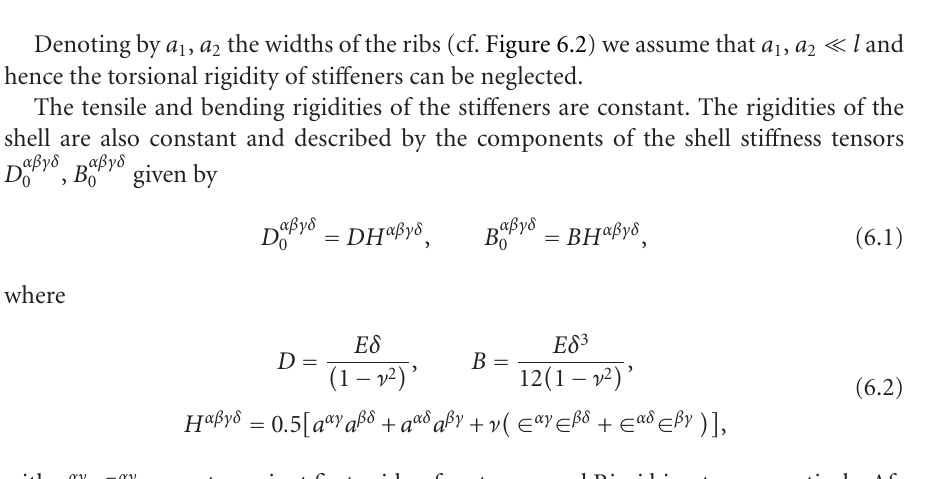
Figure 6.3. A periodicity cell along the O Θ 2 -axis direction on O Θ 1 Θ 2 -plane, a 1 , a 2 (cid:5) l